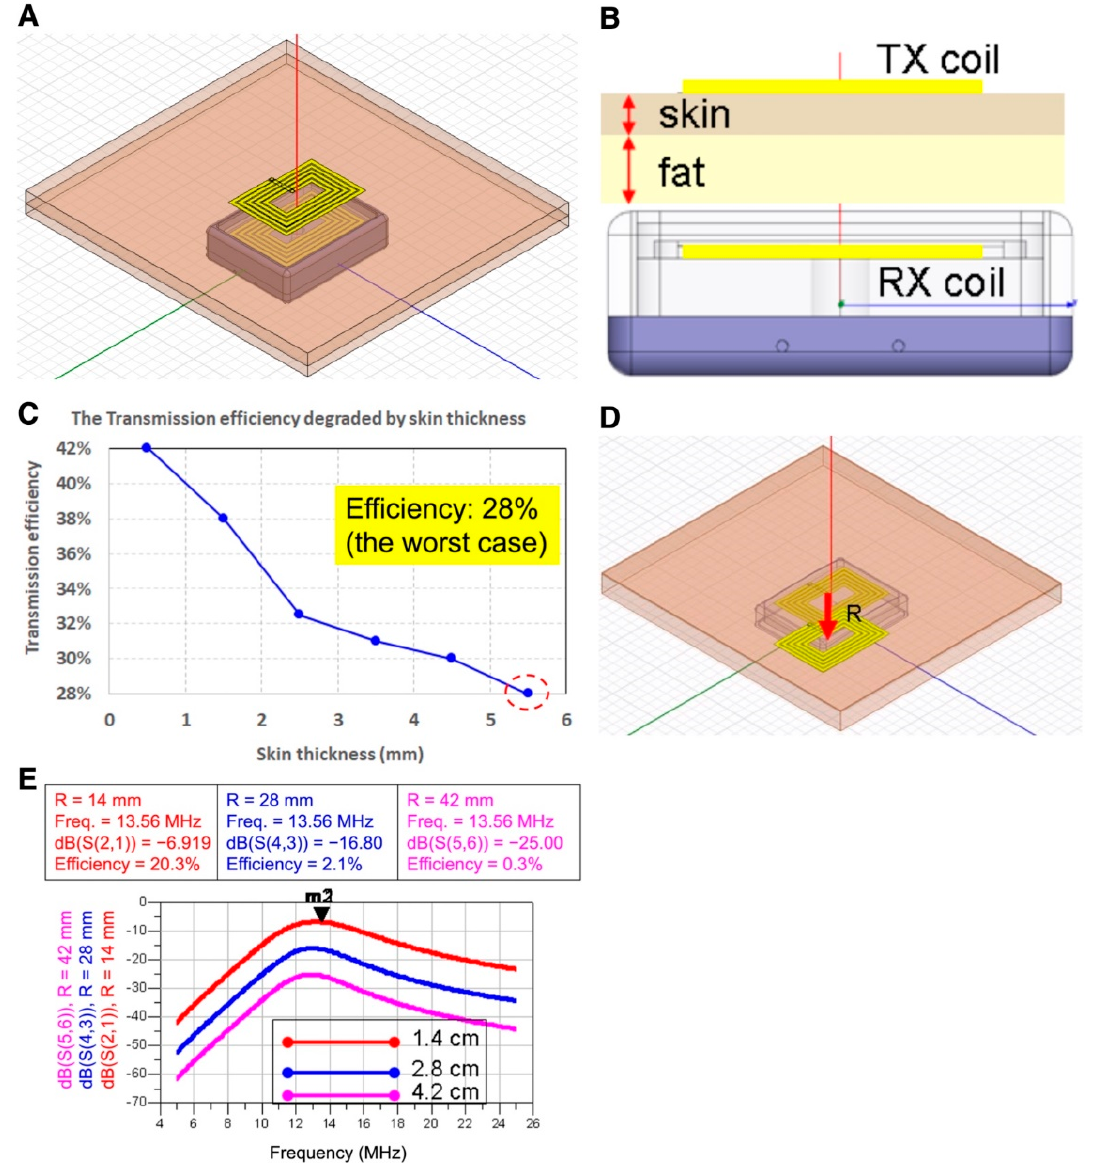
Figure 2. Effects of the skin tissue thickness and the misalignment of the cortex wire on the wireless energy transmission efficiency. ( A ) Skin tissue is placed in the simulation model. ( B ) Transversal view of skin tissue placed between the cortex wires in the transmitter and receiver. ( C ) Transmission efficiency is influenced by the thickness of skin tissue. ( D ) Analysis illustration of the cortex wire’s misalignment. R indicates the distance between the transmitter core and receiver core. (E) Simulation analysis of misalignment. R-values are 1.4, 2.8, or 4.2 cm